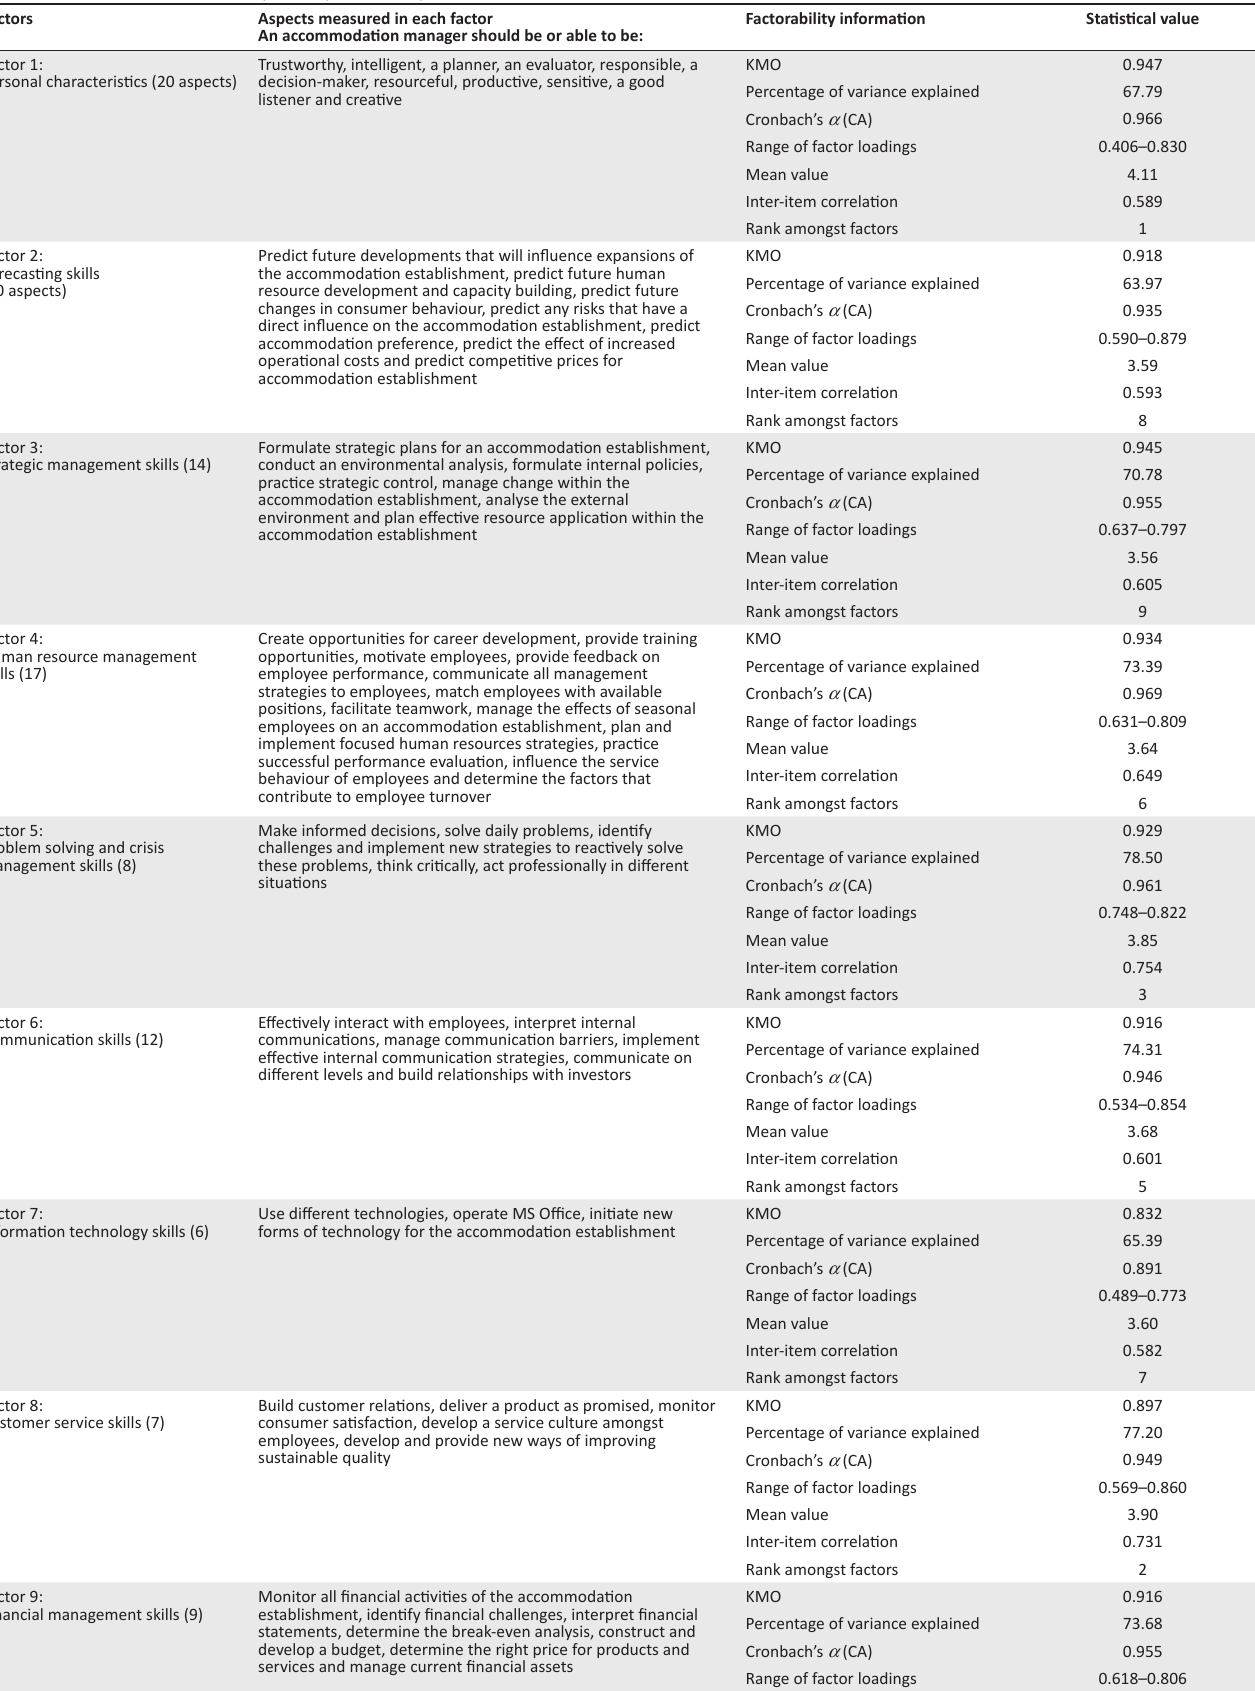
TABLE 4: Summative results of the exploratory factor analyses.